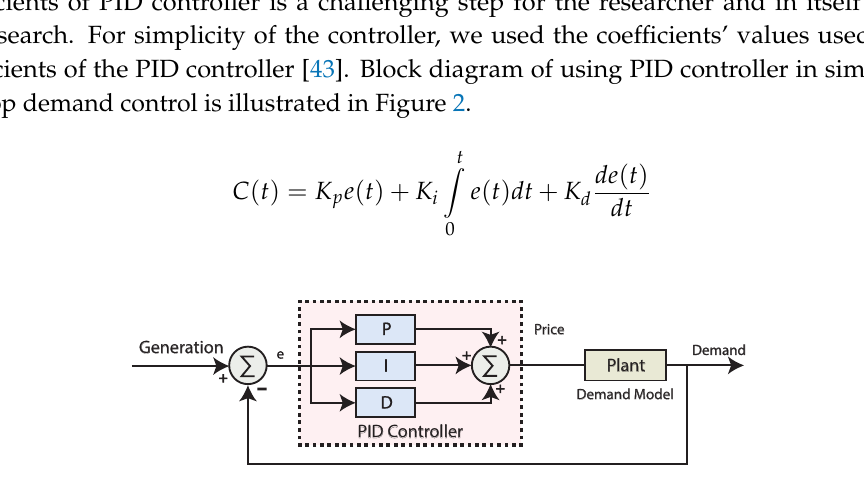
Figure 2. Block diagram of simulations using a proportional integral derivative (PID) controller in using closed-loop elastic demand